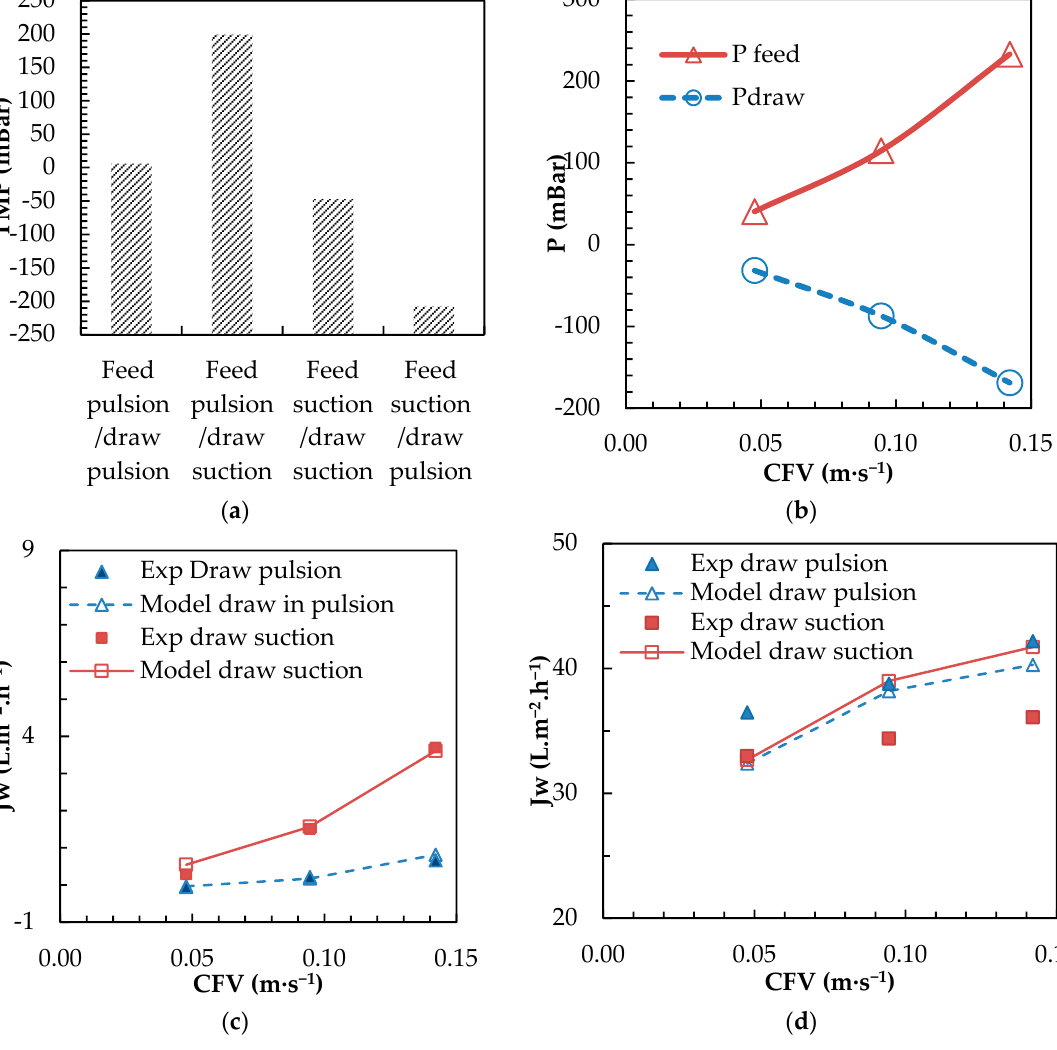
Figure 5 . Tests with CFC cells. ( a ) Impact of feed and draw pumping modes on TMP (CFV of 0.9 m · s − 1 for both feed and draw channels, DI as feed and draw), ( b ) impact of feed and draw CFV on respective feed and draw channel pressure (feed operated in pulsion, draw in suction, DI as feed and draw) and comparison of experimental and modelled water flux values ( Jw ) for different CFVs and operation of draw either in suction or pulsion with ( c ) DI as feed and draw and ( d ) DI as feed and 35 g L − 1 sea salts as draw.